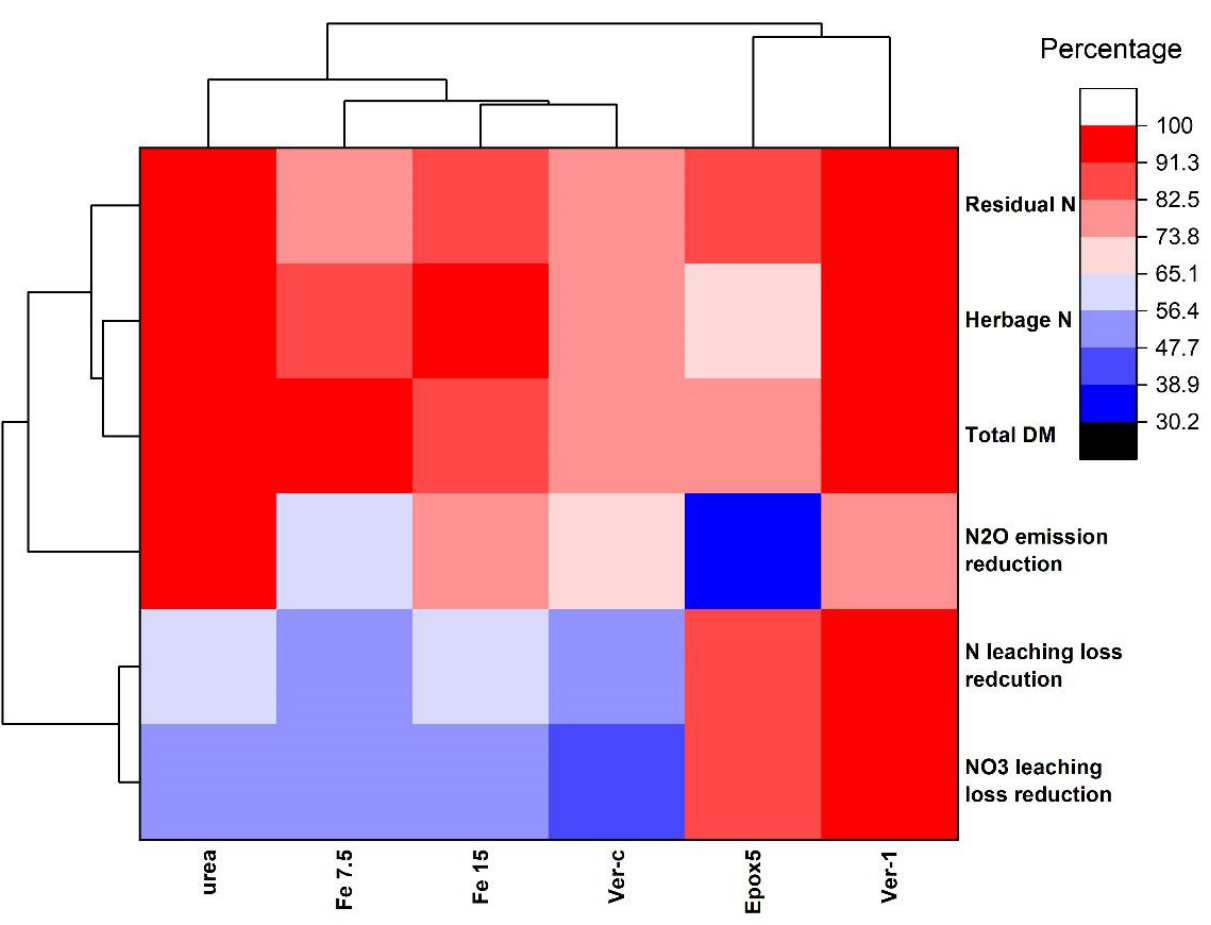
Figure 7. The hierarchical clustering heatmap for the classification of N treatments, based on the nitrate leaching loss reduction, total N leaching loss reduction, total DM yield, herbage N, and soil residual N. The values of all variables are in percentage (not absolute values).